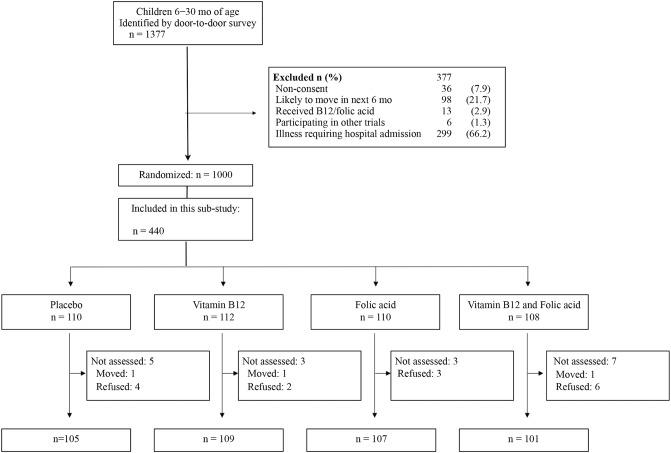
Trial profile of a randomized, placebo controlled trial on the effect of vitamin B12 and/or folic acid administration on development in 6–30 months old North Indian children.